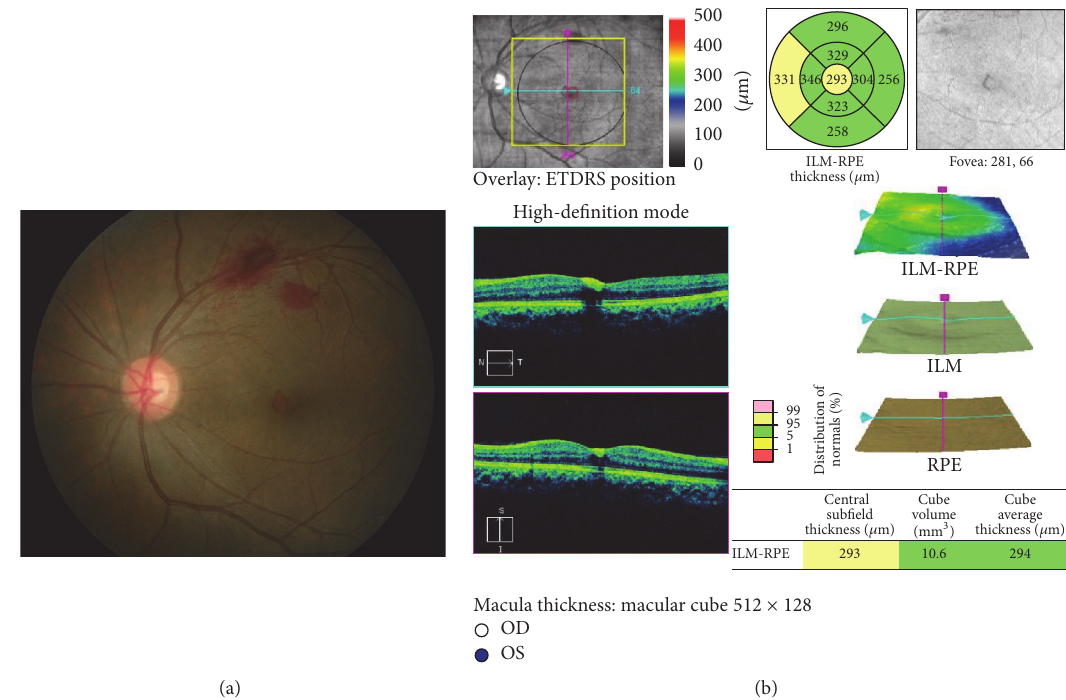
Figure 5: Case 2 at 1 month after intravitreal ranibizumab. Notes. (a) Resolution of preretinal haemorrhage in the left eye at 1 month after intravitrealranibizumab.(b)Opticalcoherencetomographyshowedminimalresidualpreretinalhaemorrhageatthefoveawithnormalretinal layer of the left eye at 1 month after intravitreal